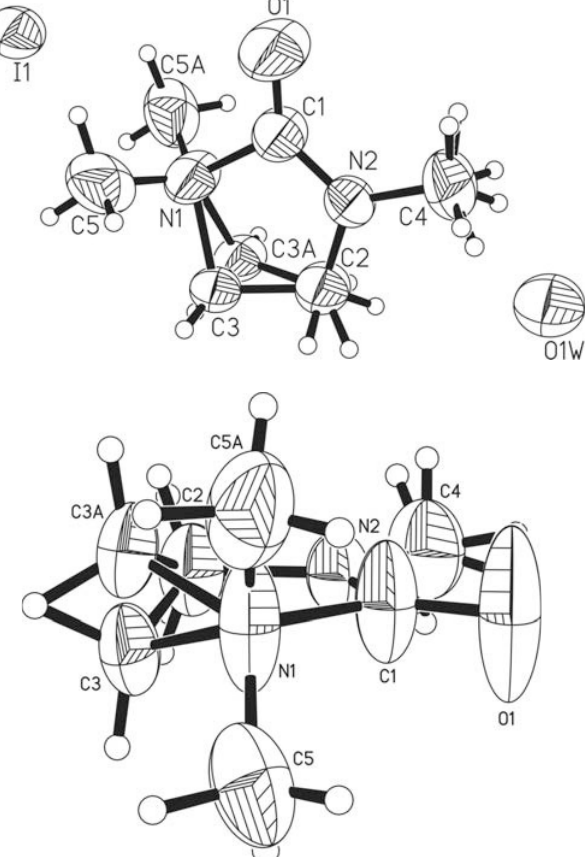
Table 1. Data collection and